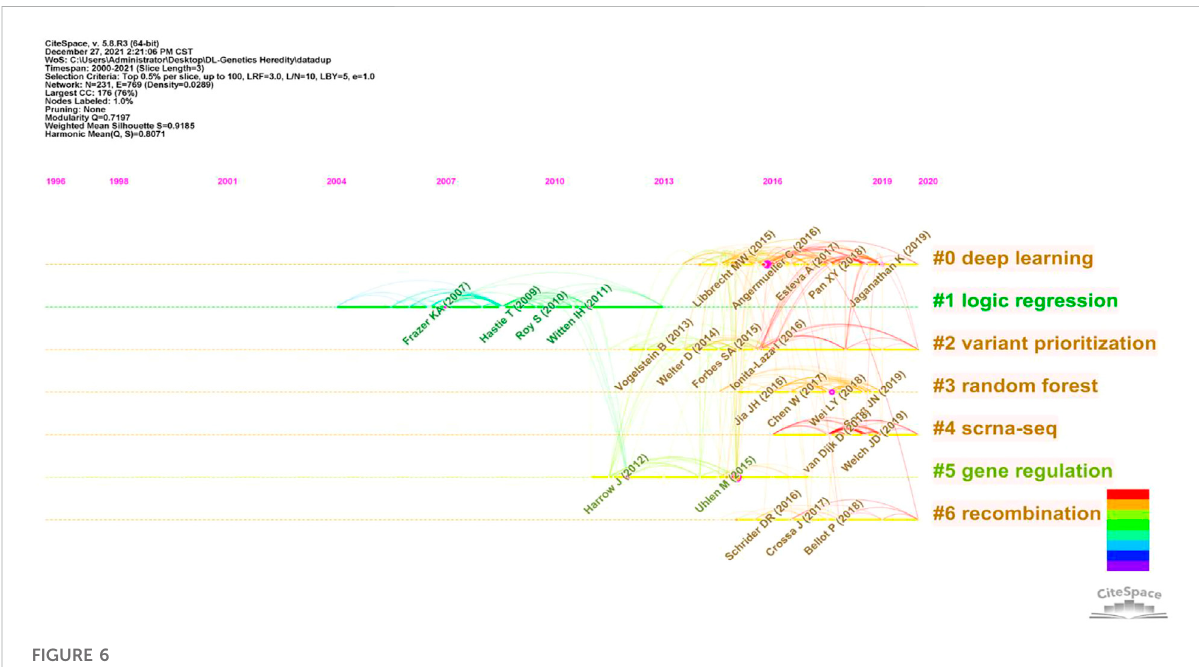
FIGURE 6 Reference co-citation map of publications from 2000 to 2021.